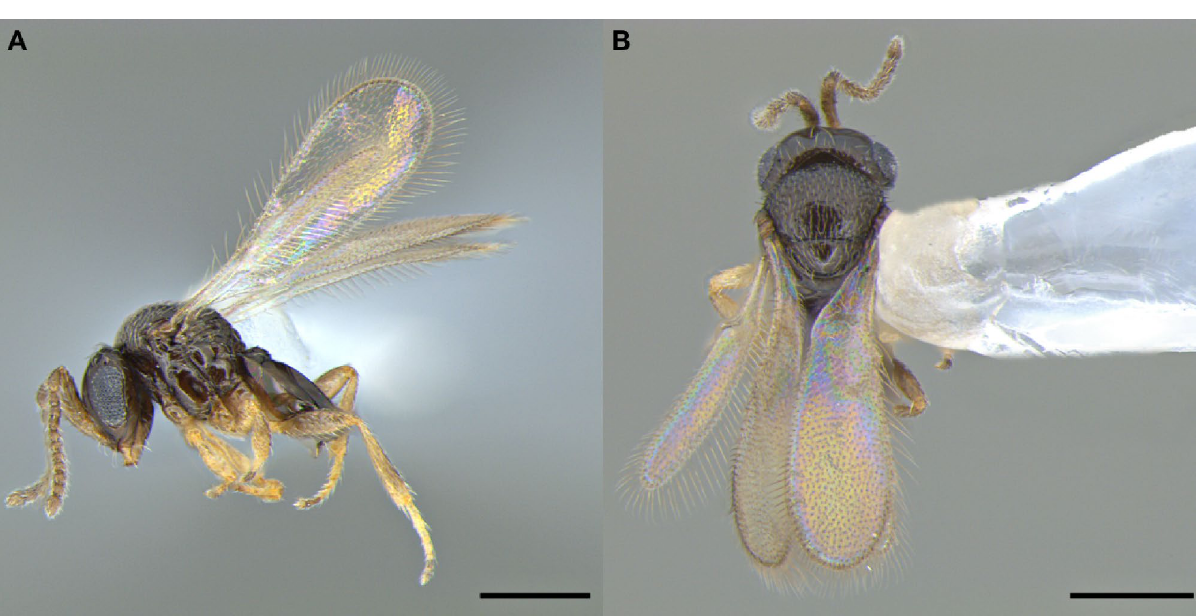
Figure 2. Telenomus remus male (scale bare: 0.20 mm): ( A ) Side view. ( B ) Dorsal